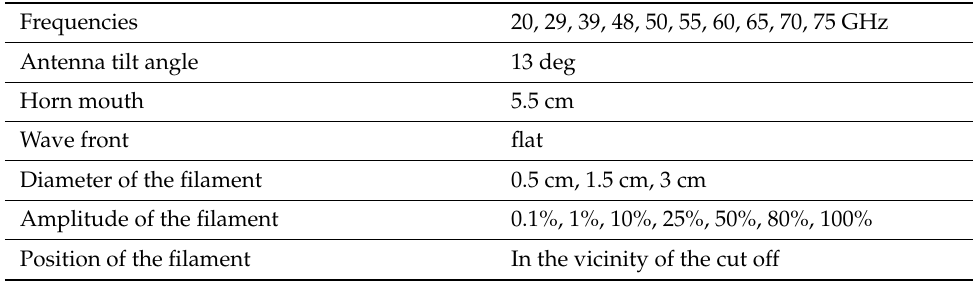
Table 5. Parameters of the performed modelling for the stretched